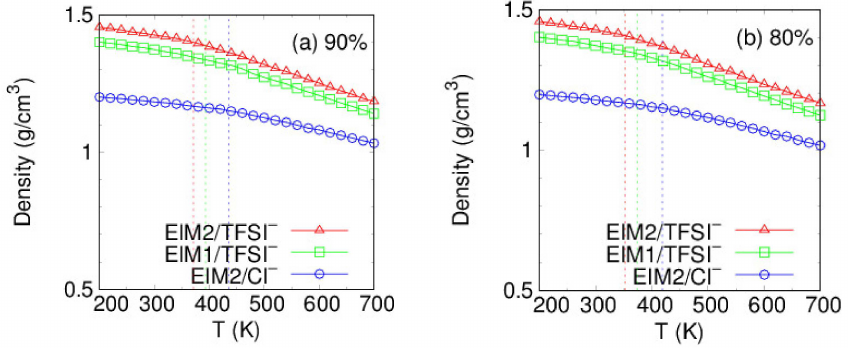
Figure 6. Temperature-dependent density profiles of the PILs at ( a ) ϕ = 90 and ( b ) 80%.